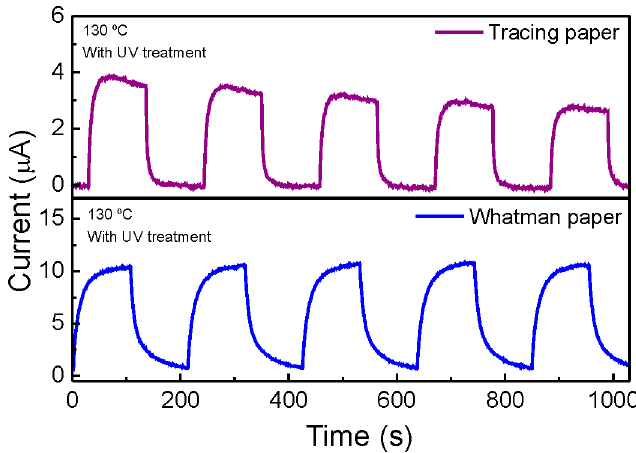
Figure 11. Cycling behavior of cellulosic ZnO nanorods UV sensors grown on tracing paper and on Whatman paper.